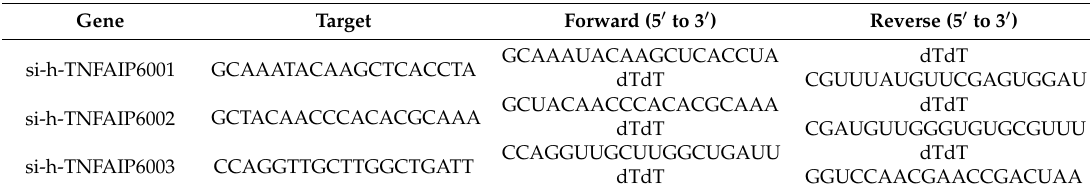
Table 2. The list of small interfering RNAs